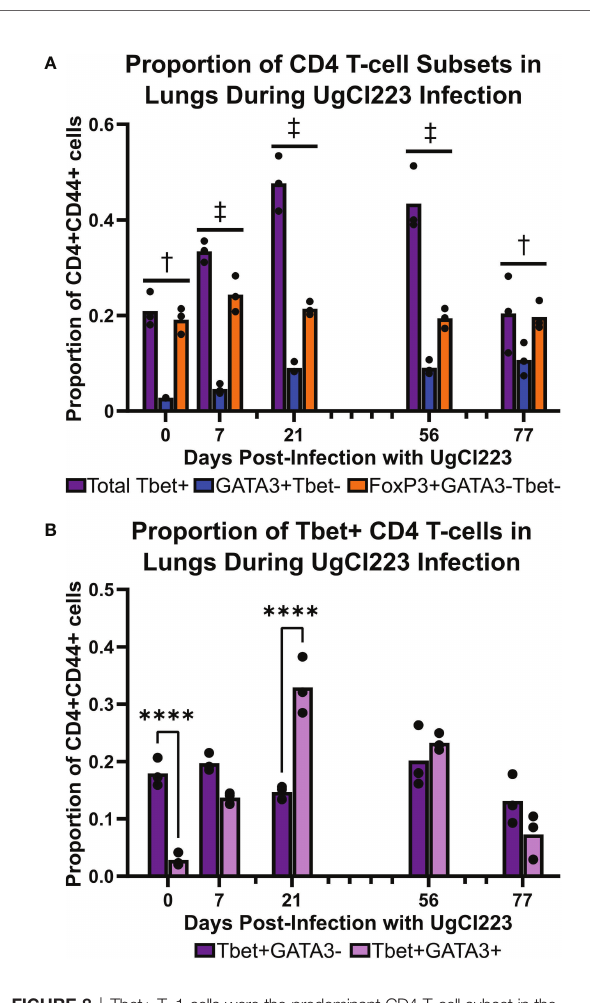
FIGURE 8 | Tbet+ T H 1 cells were the predominant CD4 T-cell subset in the lungs during the majority of the UgCl223 infection. (A) Flow cytometric analysis showing the proportions of CD4+CD44+Tbet+FoxP3- (T H 1), CD4+CD44+FoxP3+ (T REG ), and CD4+CD44+GATA3+FoxP3- (T H 2) cells over time at 0-, 7-, 21-, 56-, and 77-days post-infection. n=3 mice per timepoint. Statistical analysis performed by 2-way ANOVA with Bonferroni correction. † denotes P<0.05 for Tbet+ vs. GATA3+Tbet- and GATA3+Tbet- vs. FoxP3+GATA3-Tbet-. ‡ denotes P< 0.0001 for Tbet+ vs. GATA3+Tbet-; P < 0.05 for Tbet+ vs. FoxP3+GATA3-Tbet-; and P < 0.001 for GATA3+Tbet- vs. FoxP3+GATA3-Tbet-. (B) Flow cytometric analysis showing the proportions of CD4+CD44+Tbet+GATA3-FoxP3- and CD4+CD44 +Tbet+Gata3+FoxP3- cells over time at 0-, 7-, 21-, 56-, and 77- days post- infection. ****p < 0.0001 by 2-way ANOVA with Bonferroni correction.